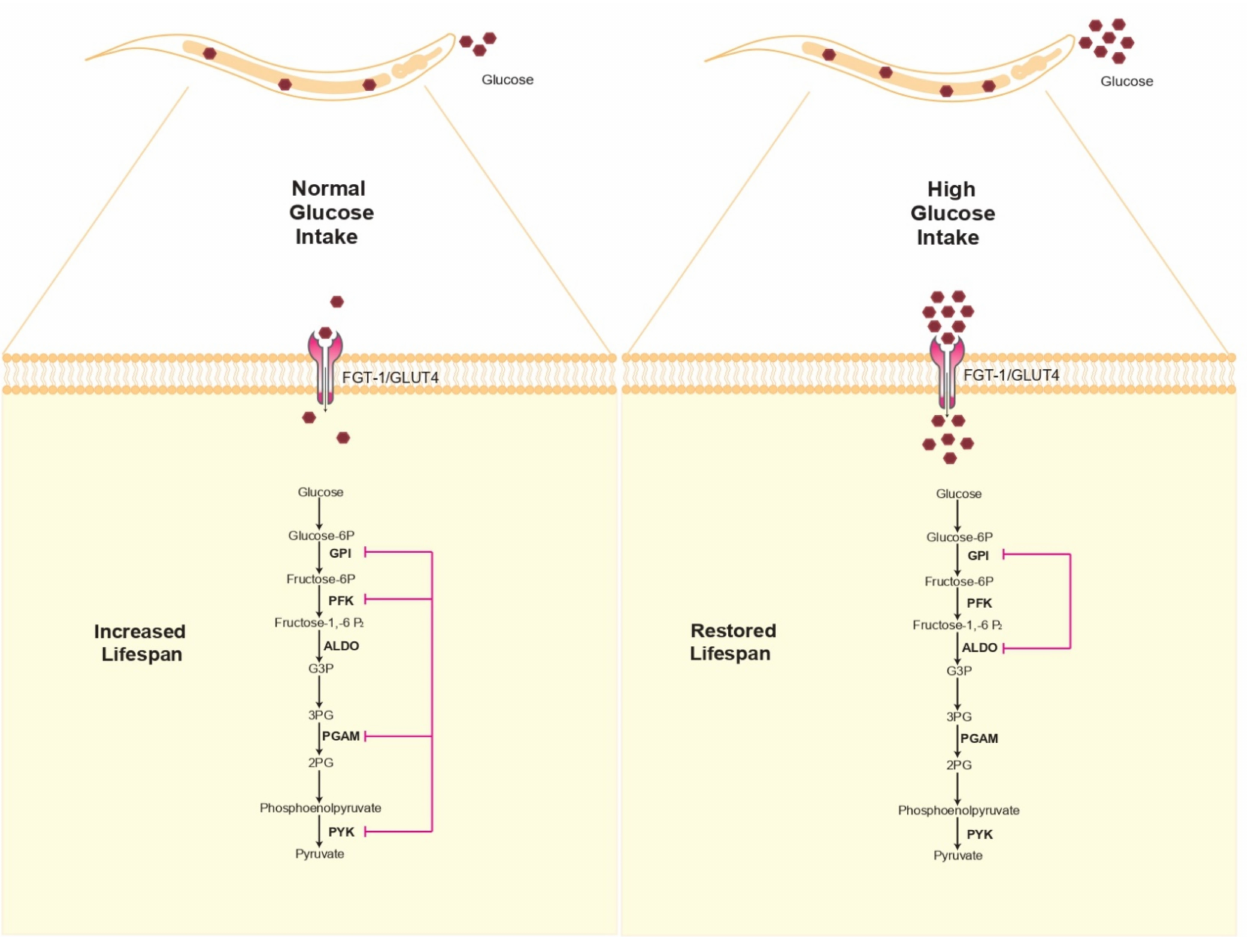
Figure 2. Effects of high glucose in C. elegans . Under standard feeding conditions, genetic inhibition of several glycolytic enzymes increases lifespan (left). Exposure to high dietary glucose reduces the lifespan; however, genetic blocks of GPI and ALDO glycolytic genes protect against high-glucose-induced shortened lifespan. GPI, glucose phosphate isomerase; PFK, phosphofructokinase; ALDO, fructose-1,6-bisphosphate aldolase; PGAM, phosphoglycerate mutase; PYK, pyruvate kinase; FGT-1, facilitated glucose transporter